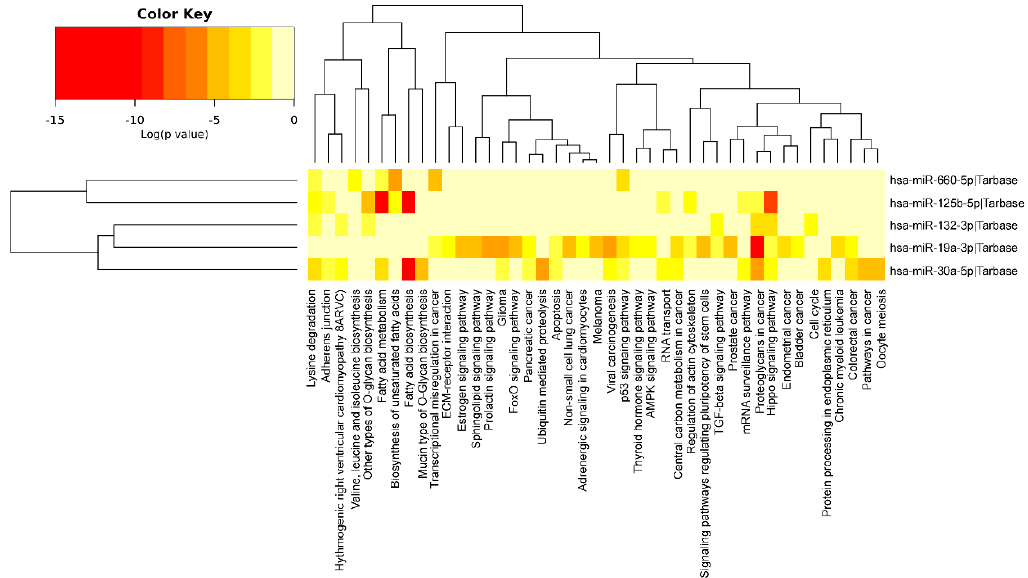
Figure 3. KEGG pathway analysis of DE miRNAs. Functional enrichment analysis of all DE miRNA target genes using KEGG pathway analysis. Log ( p -value) is indicated by a yellow-red-coloured key.